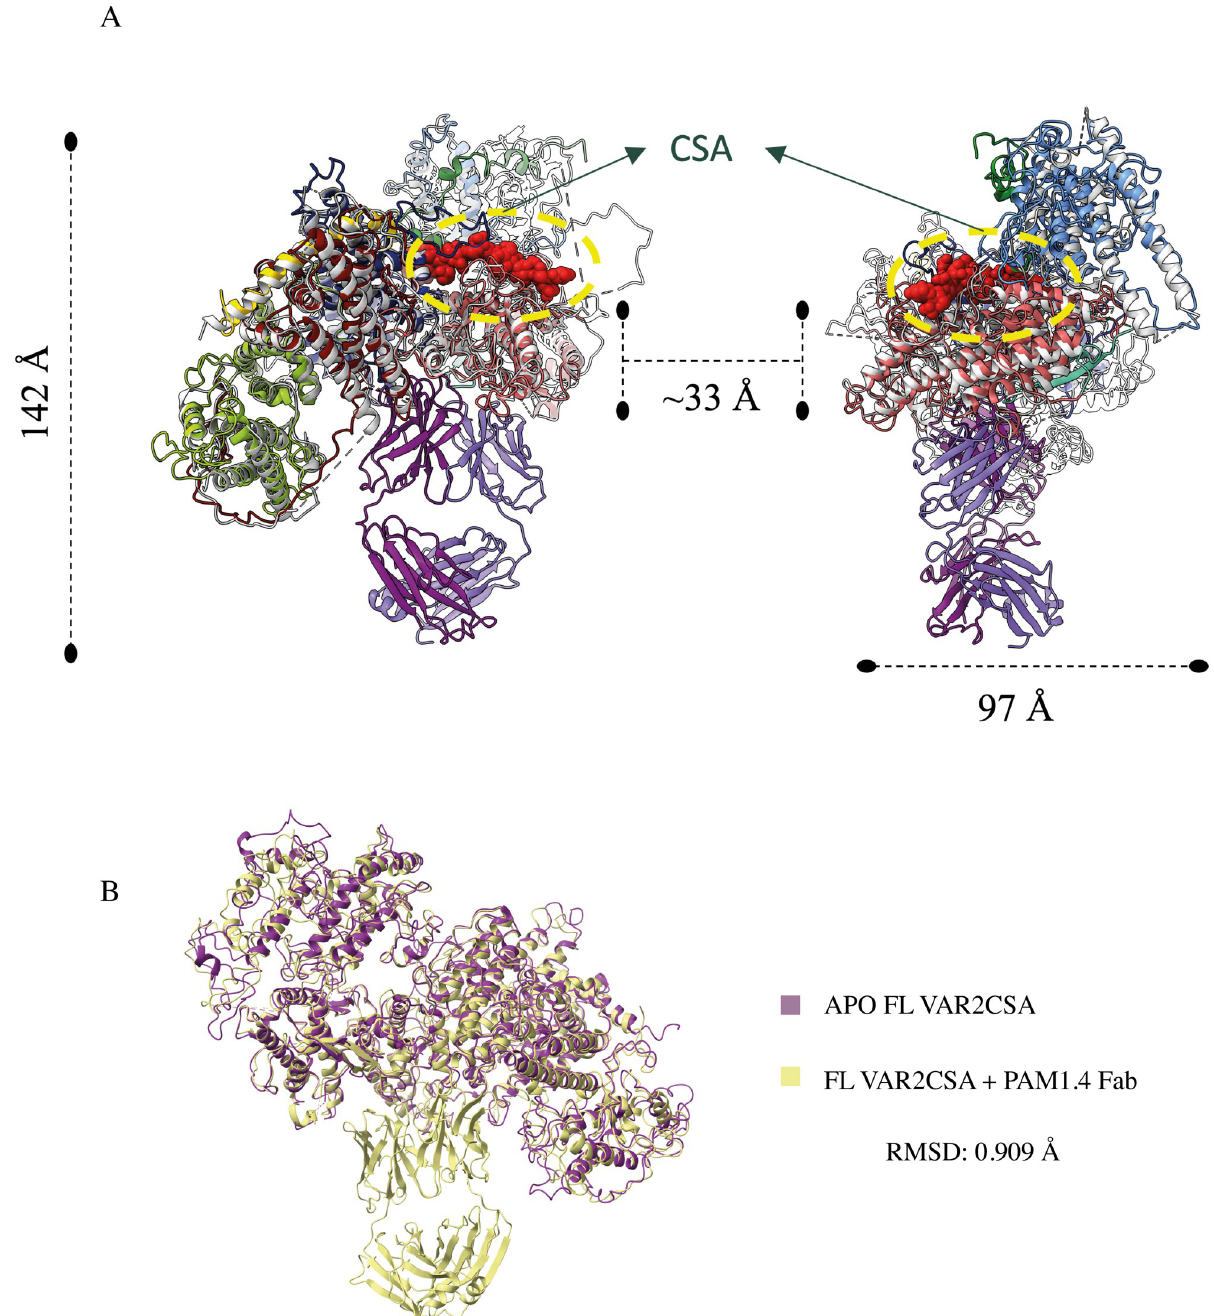
Fig 3. Overlay of VAR2CSA PAM 1.4 Fab complex structure with VAR2CSA complexed with CSA (PDB ID: 7JGH) and APO VAR2CSA. (a) Alignment of the models show no major conformational changes between the structures, generating a RMSD of 1.078 Å . CSA is shown in red spherical model and the nearest distance between the epitope of CSA and epitope of PAM 1.4 Fab is measured to be ~33 Å showing that the CSA binding site is not affected by PAM 1.4 Fab binding. (b) Overlay of APO VAR2CSA (S5 Fig) and VAR2CSA PAM 1.4 Fab complex structure. Alignment of the models shows no major conformational changes on VAR2CSA upon PAM1.4 Fab binding. RMSD: 0.909 Å .